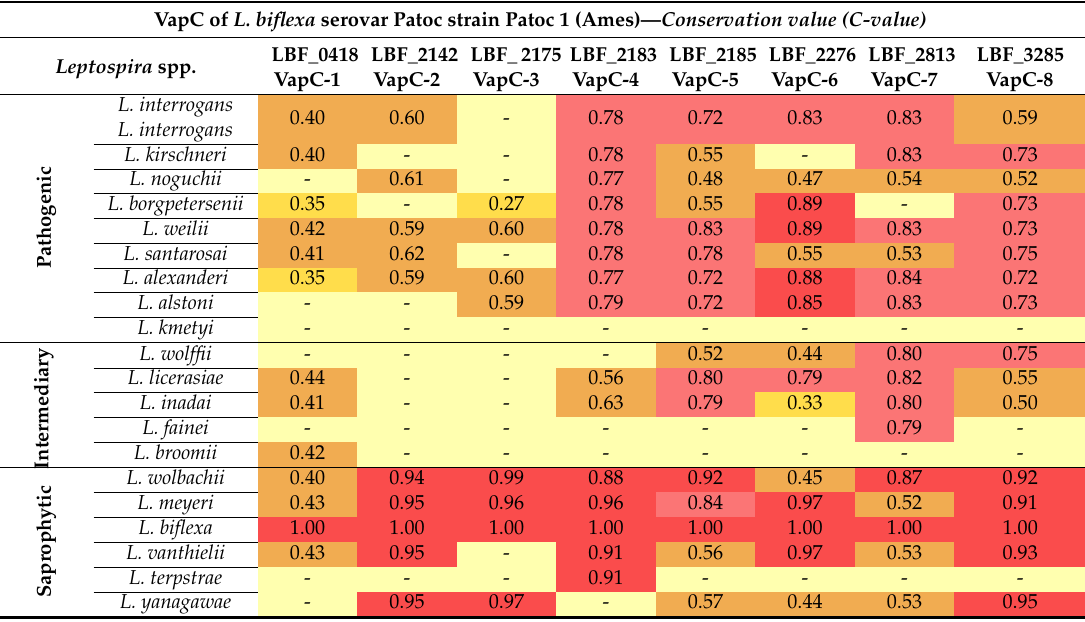
Table 2. Basic Local Alignment Search Tool (BLAST) analysis of VapCs of L. interrogans serovar Copenhageni Fiocruz L1-130.